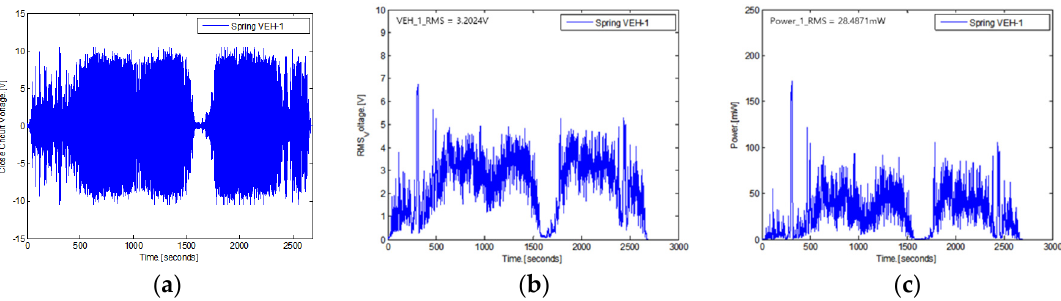
Figure 20. The performance test results of the VEH-1 device with the mechanical stopper, a 50 Hz resonant frequency and a 360 Ω load resistance: ( a ) the peak to peak voltage ( V pk-pk-veh-T ) ; ( b ) the RMS generated voltages ( V rms-veh-T ) ; ( c ) the experimentally generated power (P exp-veh-T ).